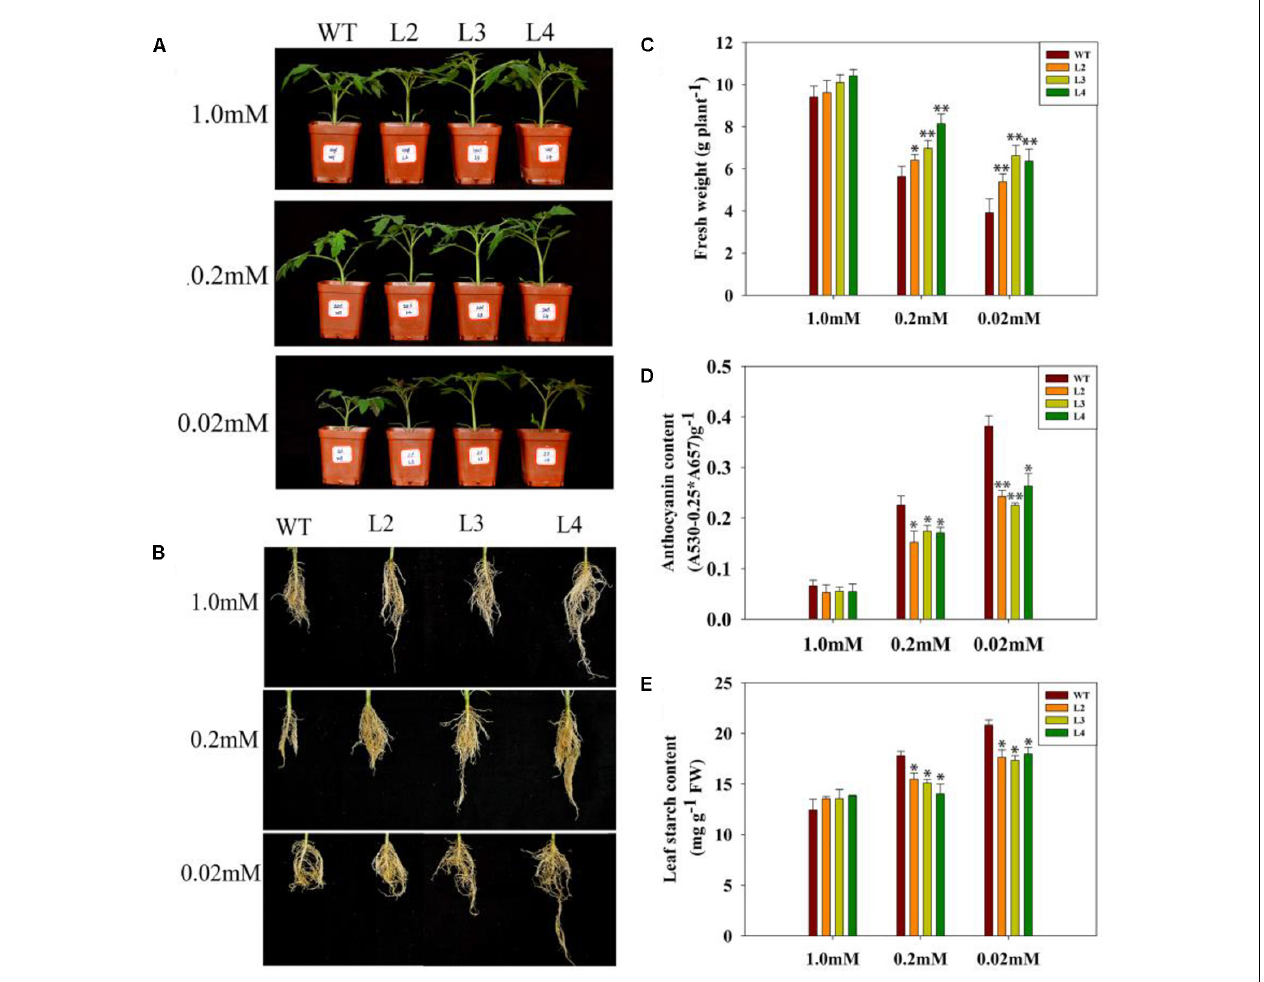
FIGURE 2 | Growth phenotype of WT and transgenic lines under variable Pi conditions. (A,B) The shoot and root phenotypes of 15-day-old WT tomato plant and three codA -transgenic tomato lines under variable Pi conditions. Seedlings (after germination) were treated with 1.0 mM phosphorus (CK), 0.2 mM phosphorus and 0.02 mM phosphorus (LP) for 15 days under sand-culture system. Then, photos were taken. (C) The whole-plant biomass of WT and transgenic lines under the various Pi concentrations as described in (A,B) . 15-day-old tomato seedlings were collected for biomass analysis. Values are means ± SD. n = 12 for each genotype. (D) Anthocyanin content in the leaves of plants treated with 1.0, 0.2, 0.02 mM phosphorus for 15 days; seedlings were subsequently harvested for measuring anthocyanin content. (E) Starch accumulation of the 15-day-old WT and transgenic lines described in (D) . Values represent means ± SD of three replicates. Asterisks indicate significant differences compared with WT plants (Student’s t -test). FW, fresh weight; ∗ P < 0.05; ∗∗ P <